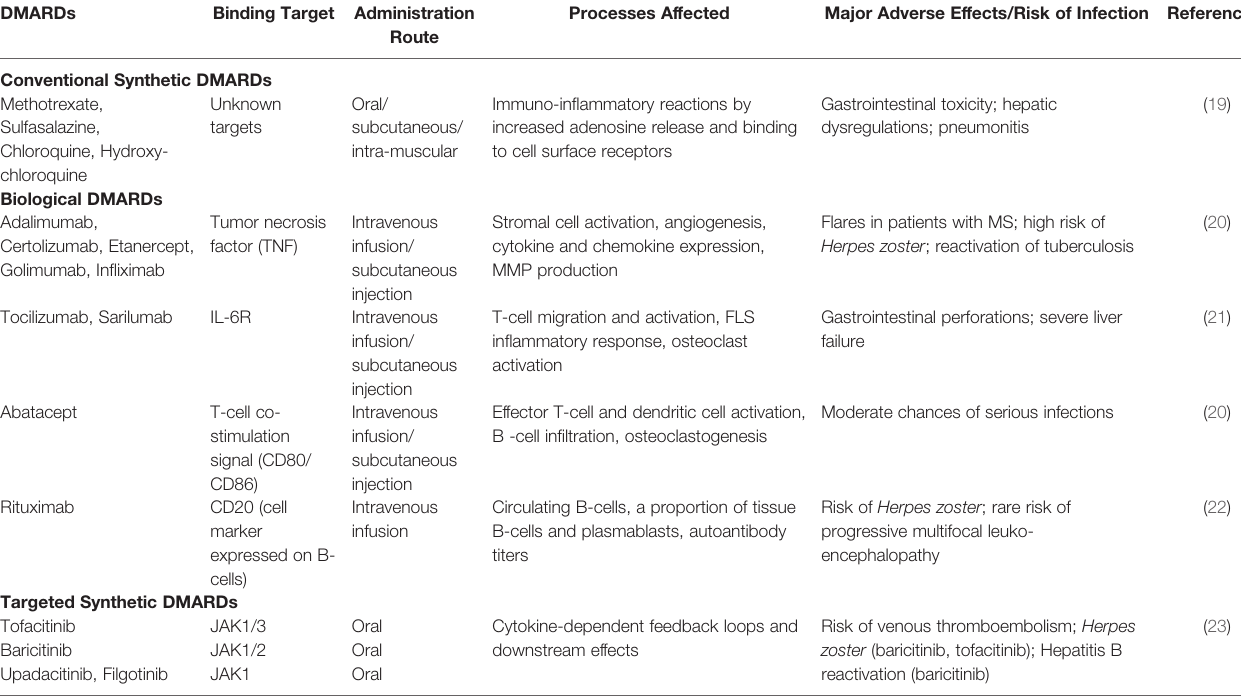
TABLE 1 | FDA approved therapies available for RA along with major adverse